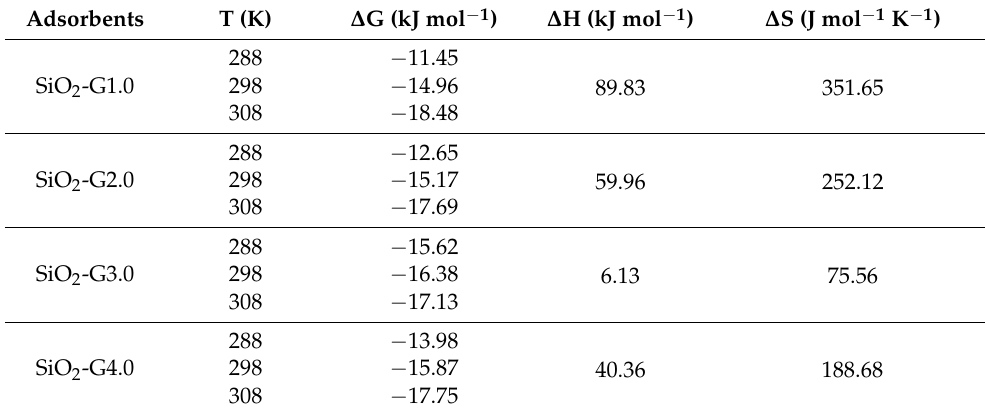
Table 1. Thermodynamic parameters for the adsorption of Mn 2+ [89]. Reprinted with permission from Ref. [89]. 2019, Elsevier.